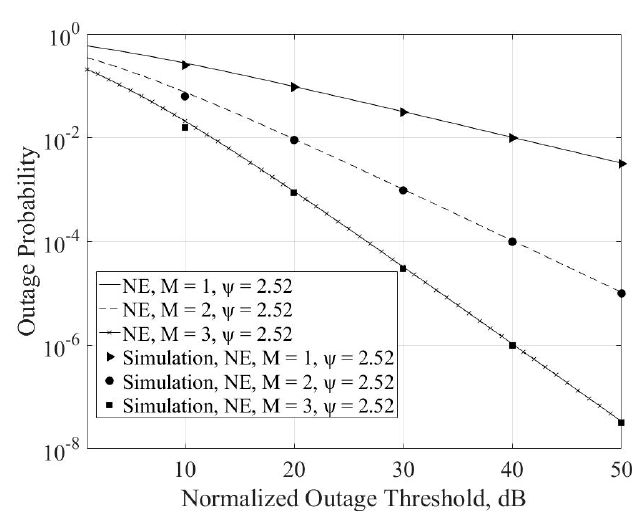
Figure 1. OP performance versus the normalized outage threshold for GG and Málaga cases.